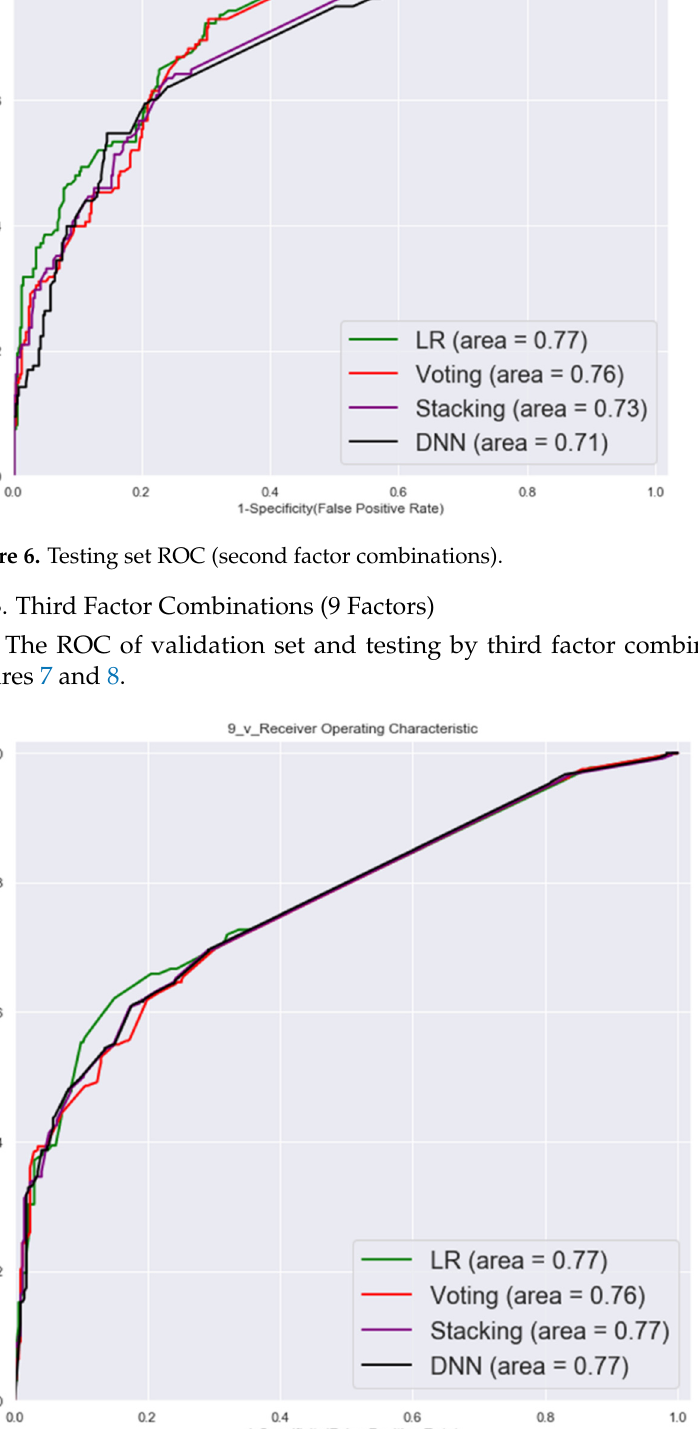
Figure 7. Validation set ROC (third factor combinations).